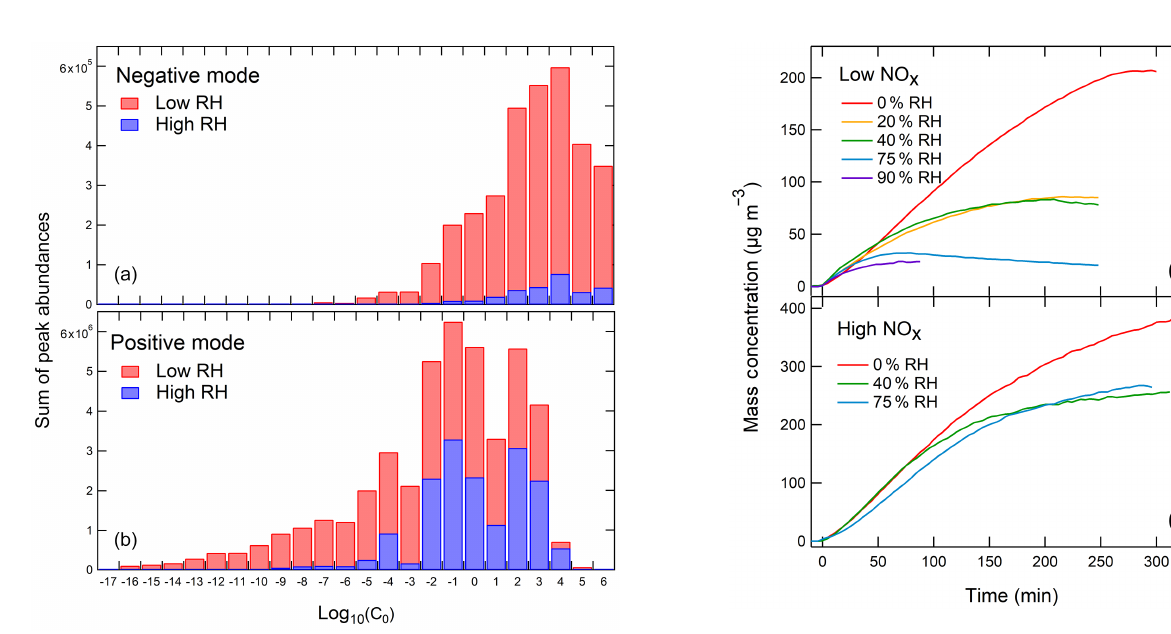
Figure 3. Estimated volatility distribution for the compounds ob- served in low-NO x SOA samples in the negative (a) and positive (b) ion mode at high (blue bars) and low (red bars) RH. The height of each bar is proportional to the total ESI abundance of compounds falling within the volatility bin.